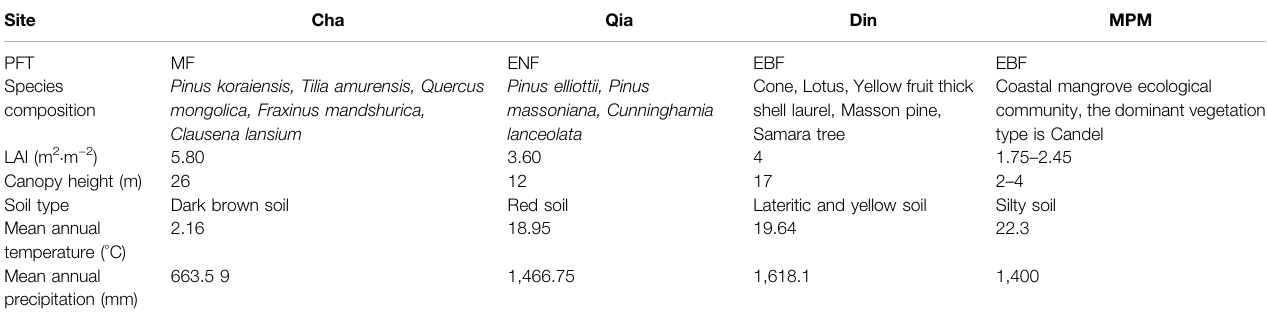
TABLE 2 | Geographic descriptions of the four forest FLUXNET sites.